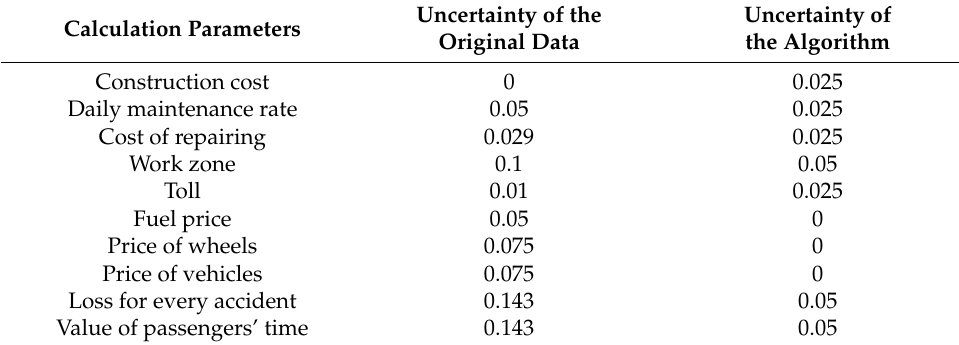
Table 4. Uncertainty of calculation parameters.